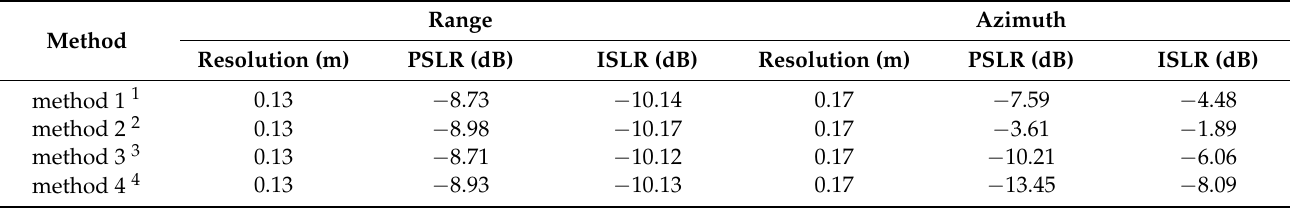
Table 4. Point target comparison results of different methods.